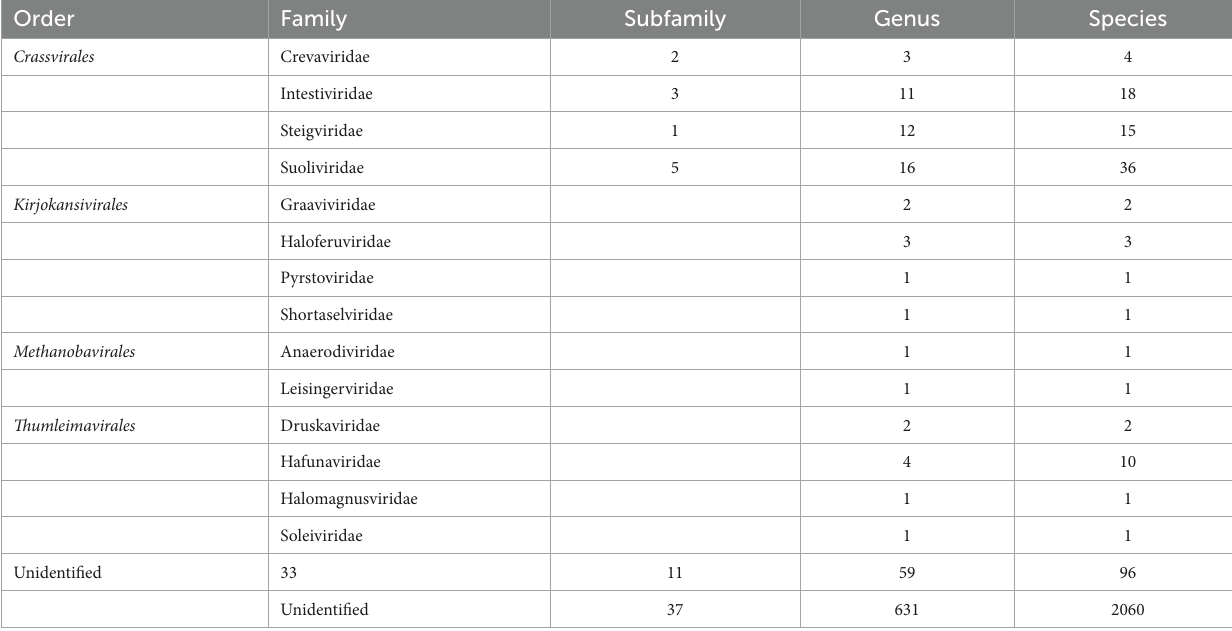
TABLE 1 Current taxonomy of the class Caudoviricetes following International Committee on Taxonomy of Viruses (ICTV).